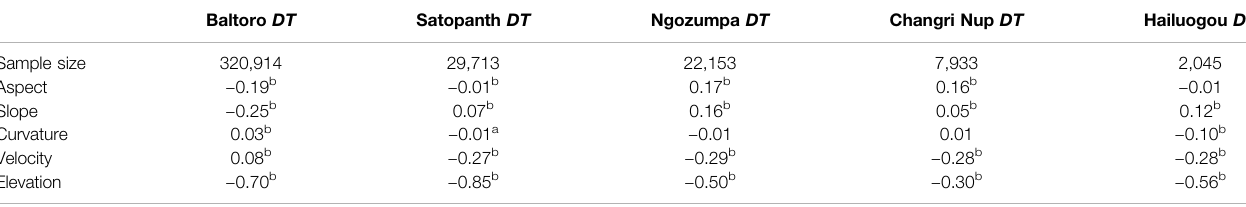
Aspect,slope,curvature,andelevationderivedfromHMA8 mDEM(Sheanetal.,2019)forSatopanth,NgozumpaandChangriNupGlaciers,andfromASTERGDEM003forBaltoroand Hailuogou Glaciers. Velocities from the NASA MEaSUREs ITS_LIVE dataset (Gardner et al., 2013). a indicates 95% con fi dence. b indicates 99% con fi